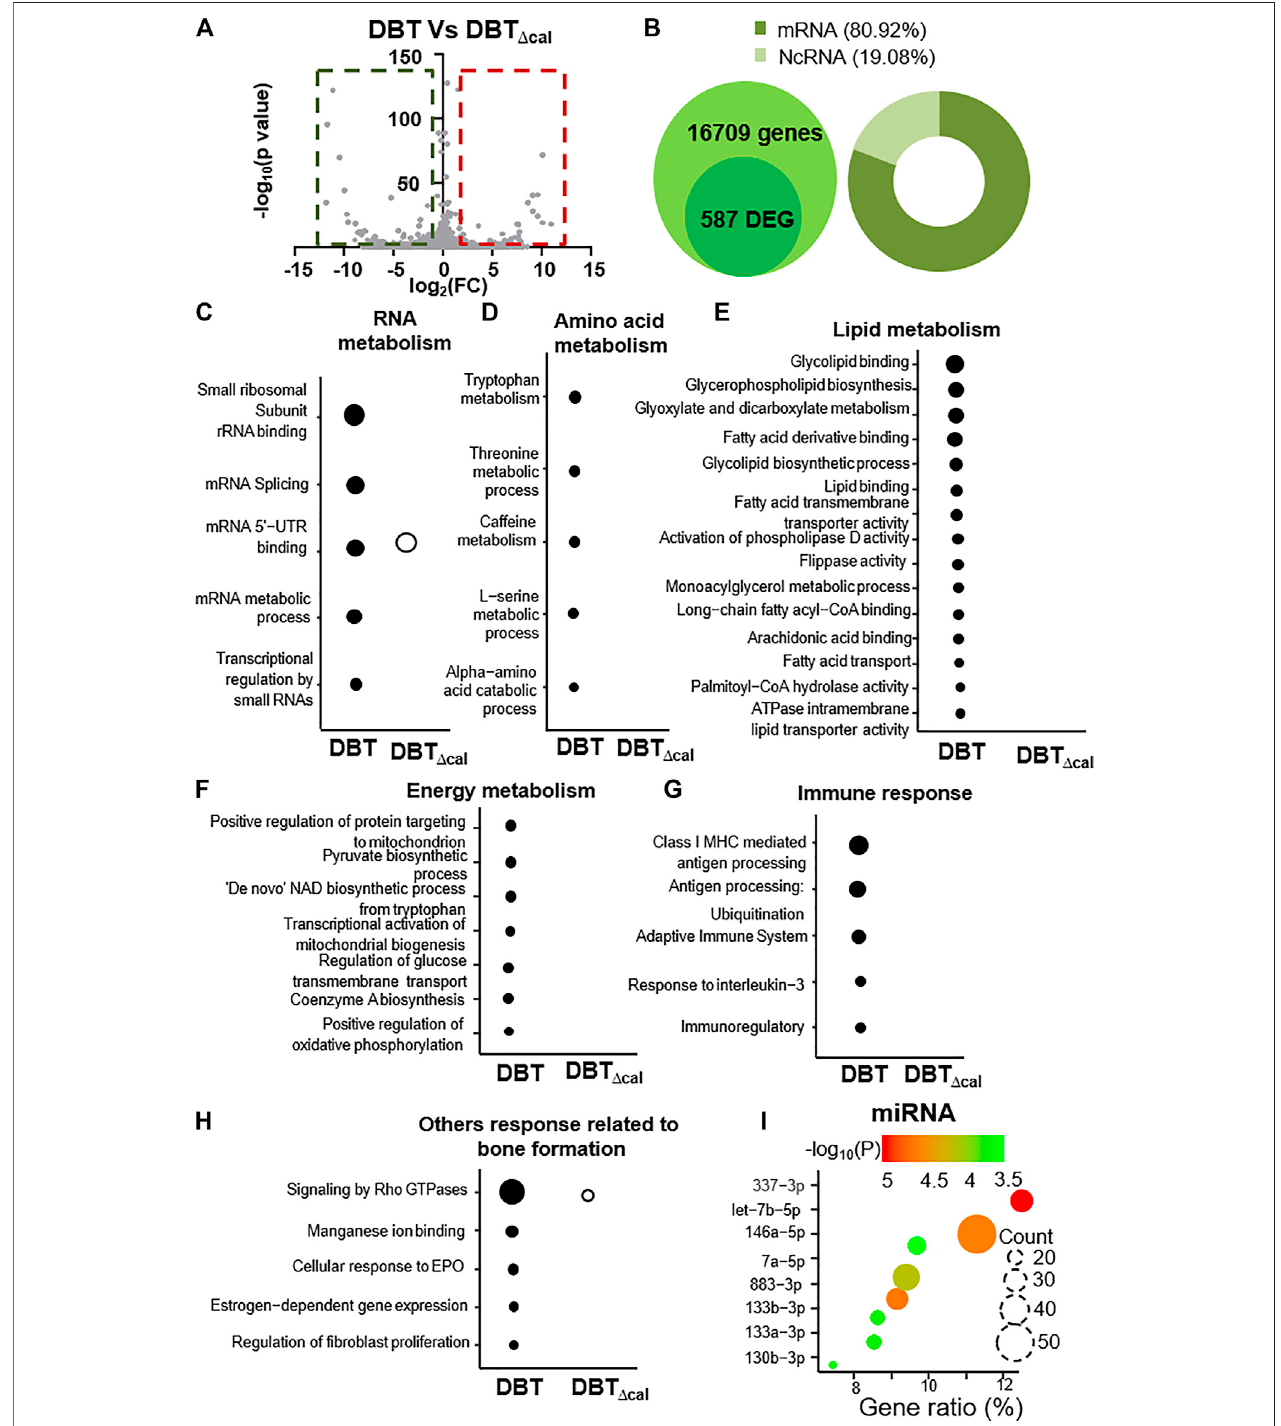
FIGURE 2 | Comparison of transcriptomics between DBT and DBT Δ cal . The treatment of osteoblasts was as that in Figure 1 . (A): In RNA-seq results for DBT and DBT Δ cal ,DEGsaredeemedsigni fi cantfor p < 0.05andfoldchangehigher/lowerthan ± 1.5,correspondingtotherectangularregions. (B): Thestatisticalsummaryoftotal detectedgenes:DEG,mRNA,andncRNA. (C – H): KOBASanalysisenrichesthesignalingpathwayinDEGsviaKEGG,Reactome,BioCye,PANTHER,andGO.Thesize of the circle represents – log 10 (P). (I): The miRNA analysis from DEGs. Gene ratio is the ratio of DEG number in corresponding to speci fi c miRNA change.